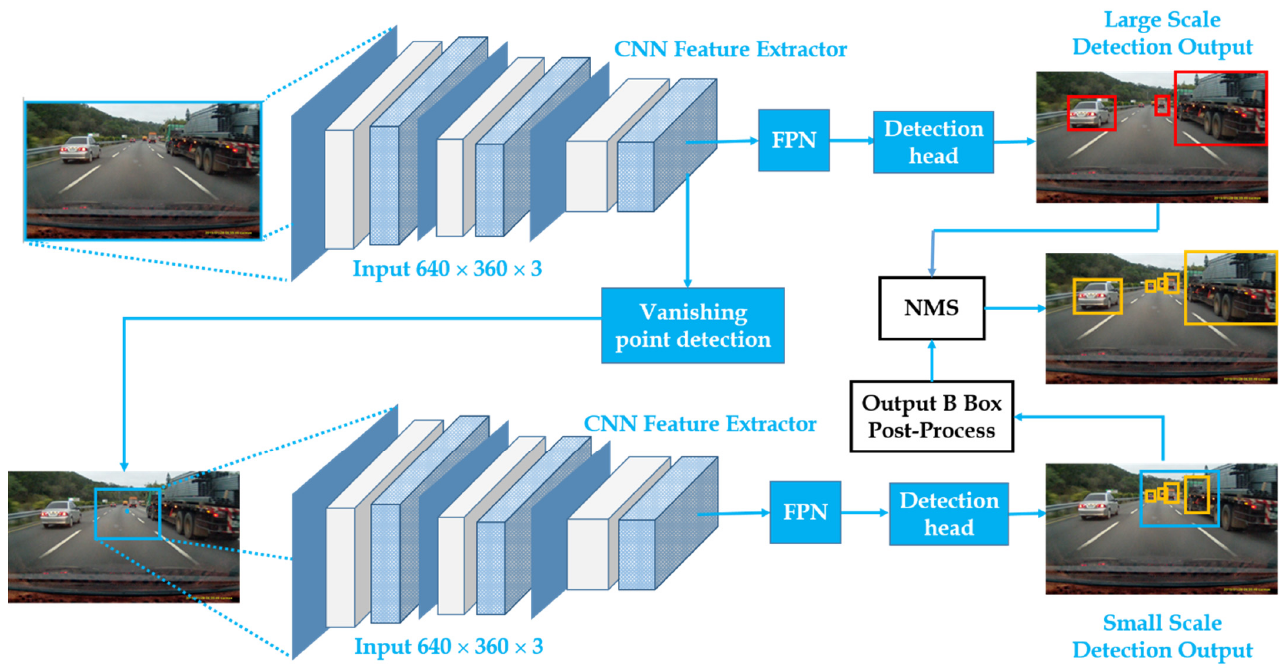
Figure 2. The architecture of the proposed ConcentrateNet model.